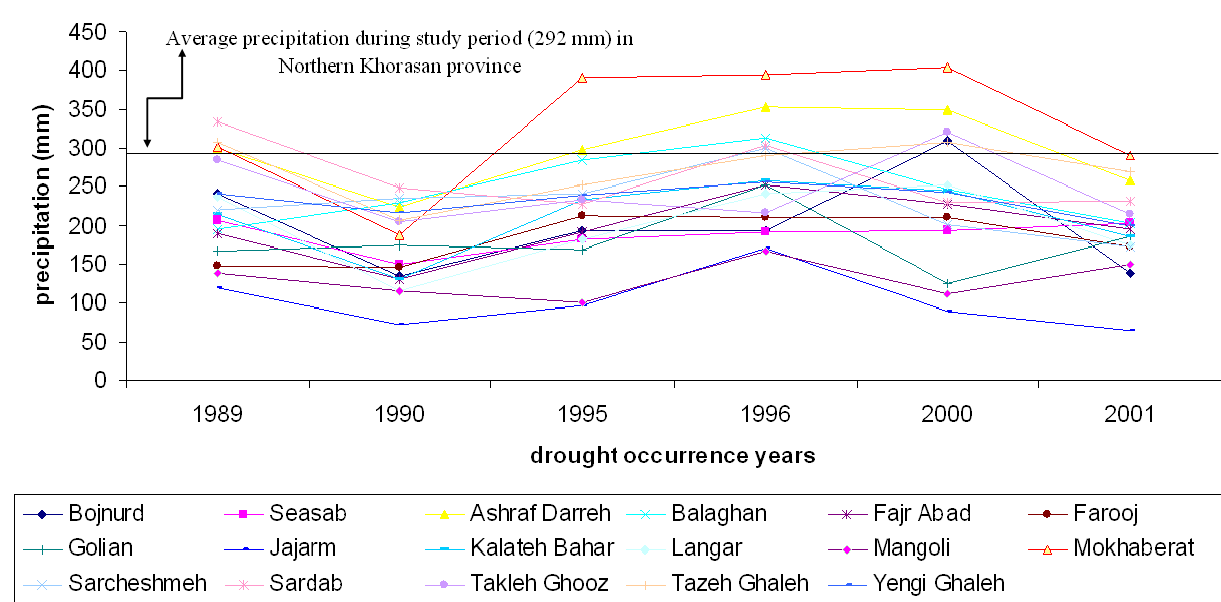
Fig. 2. Precipitation values during drought occurrence years in Northern Khorasan